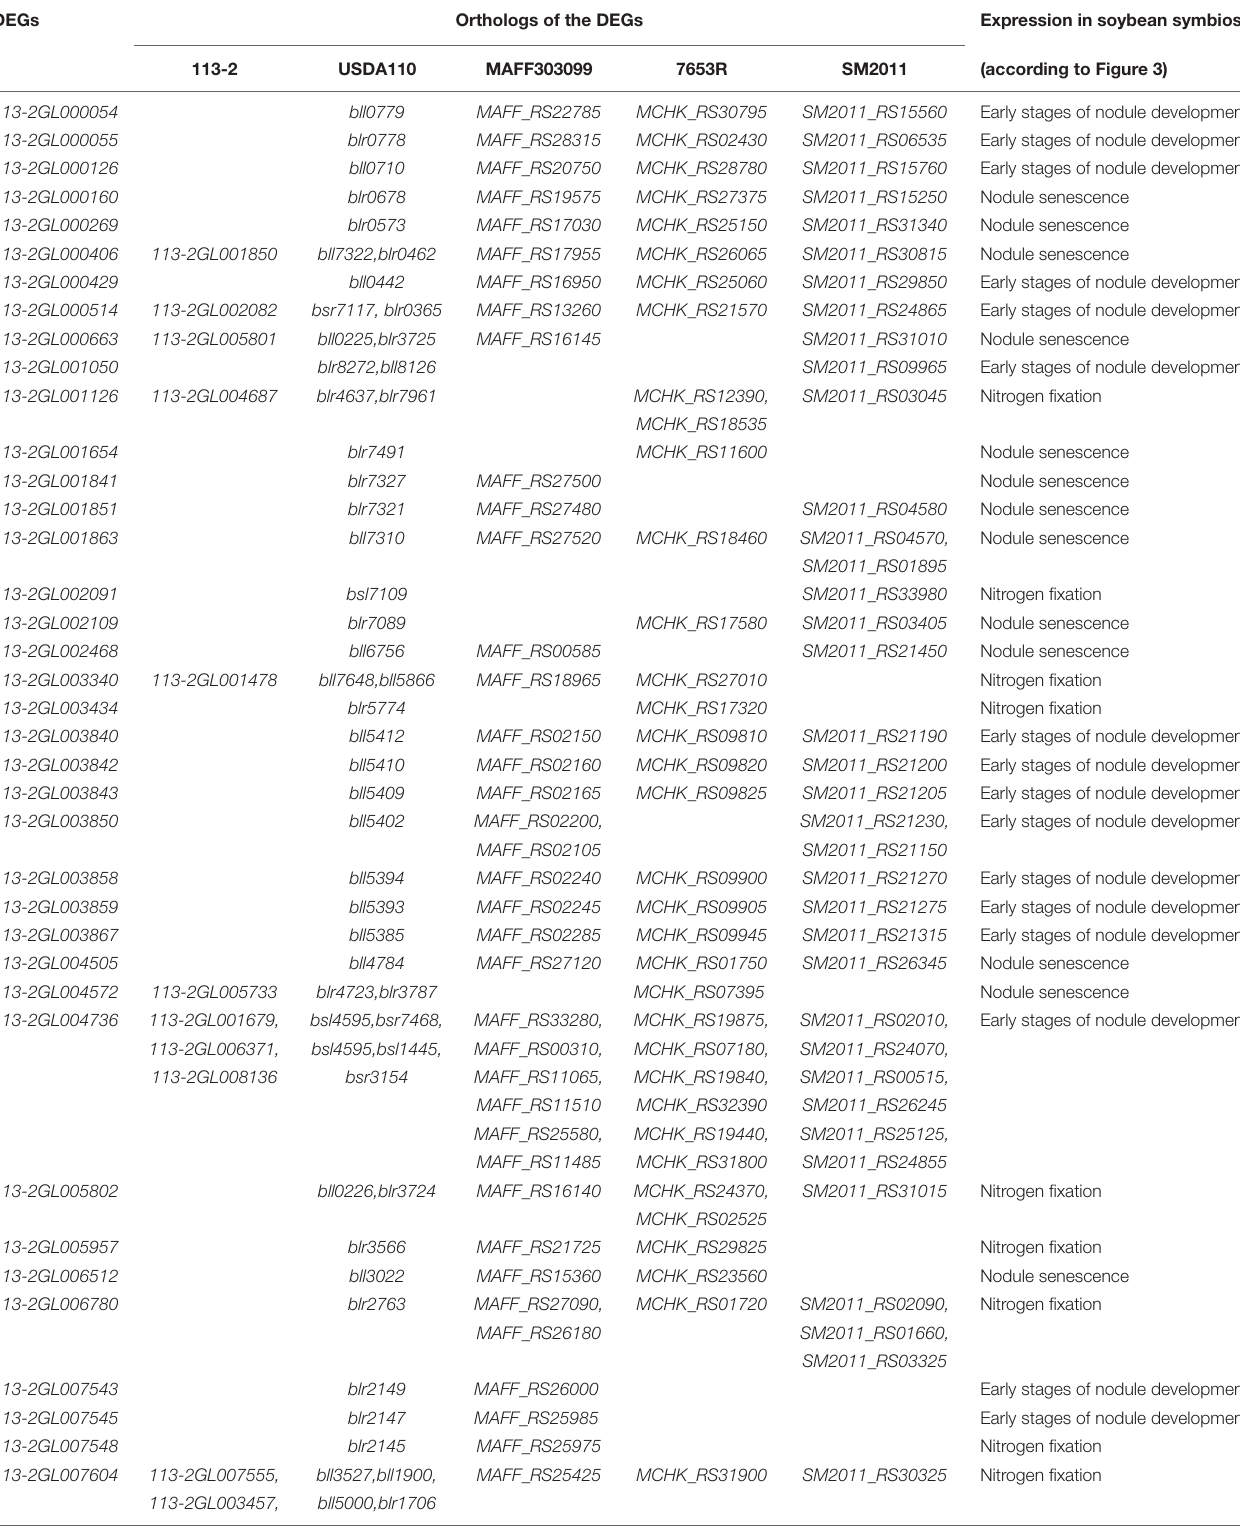
TABLE 3 | Orthologs of the selected DEGs in 113-2, USDA110, M. loti MAFF303099, M. huakuii 7653R, and S. meliloti 2011.